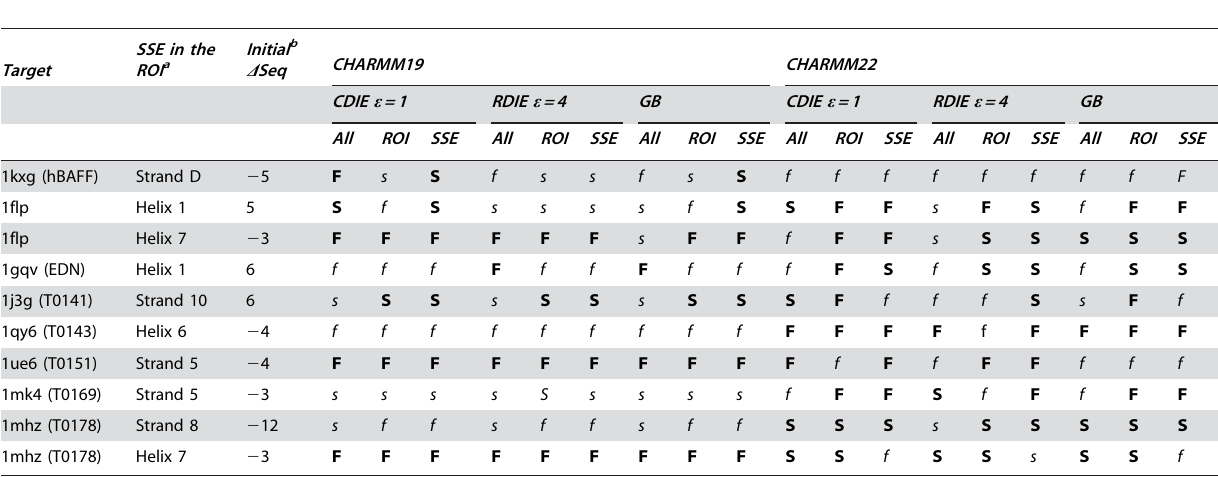
F stands for failure and S for success. When the p-value associated with the prediction is significant, the outcome is formatted in bold character, otherwise in lowercase italic.